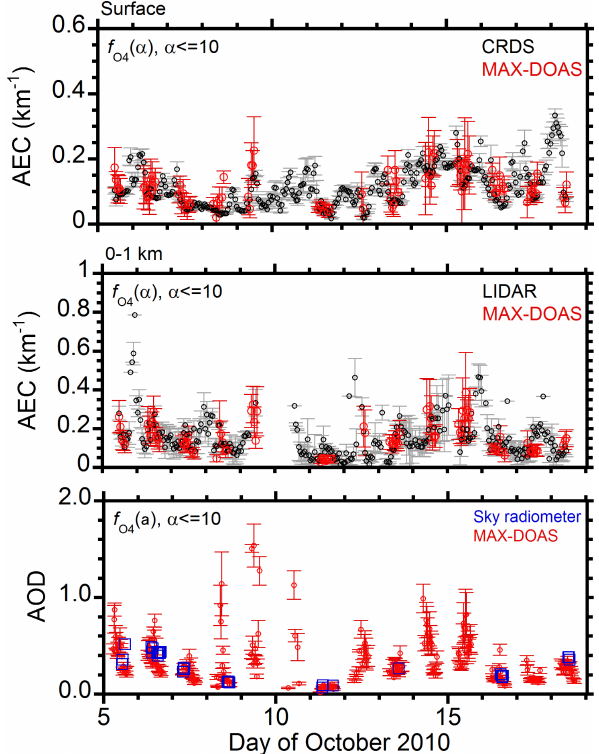
Figure 15. Same as Fig. 4, but f O in the MAX-DOAS retrieval. α used in the retrieval has been limited to ≤ 10 ◦